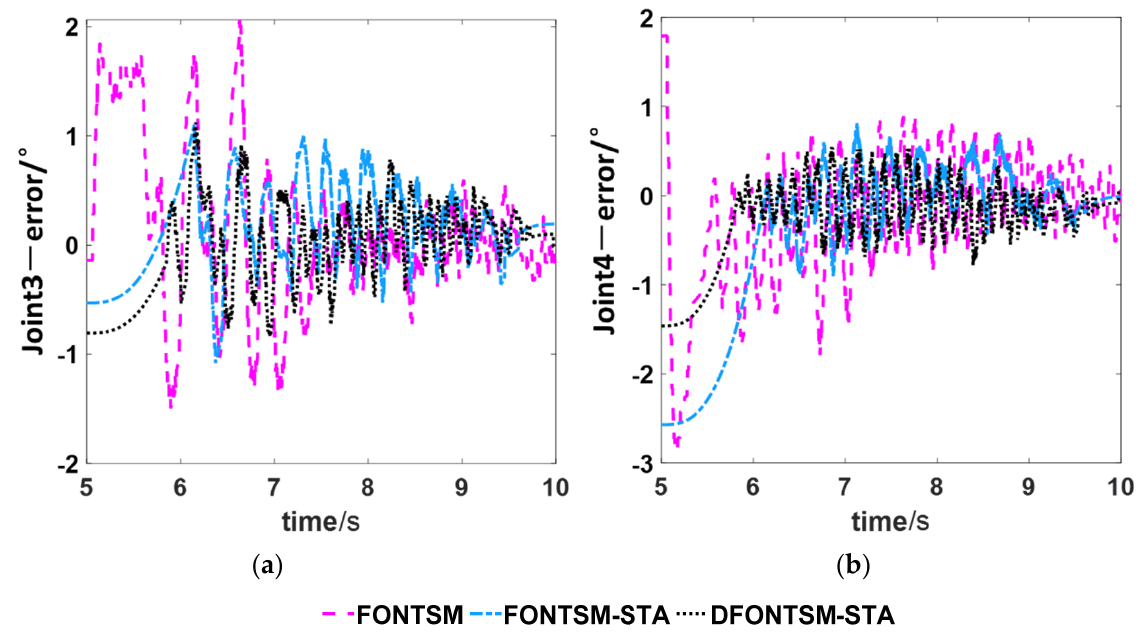
Figure 12. The position tracking error of the elbow joints. ( a ): joint three; ( b ): joint four.